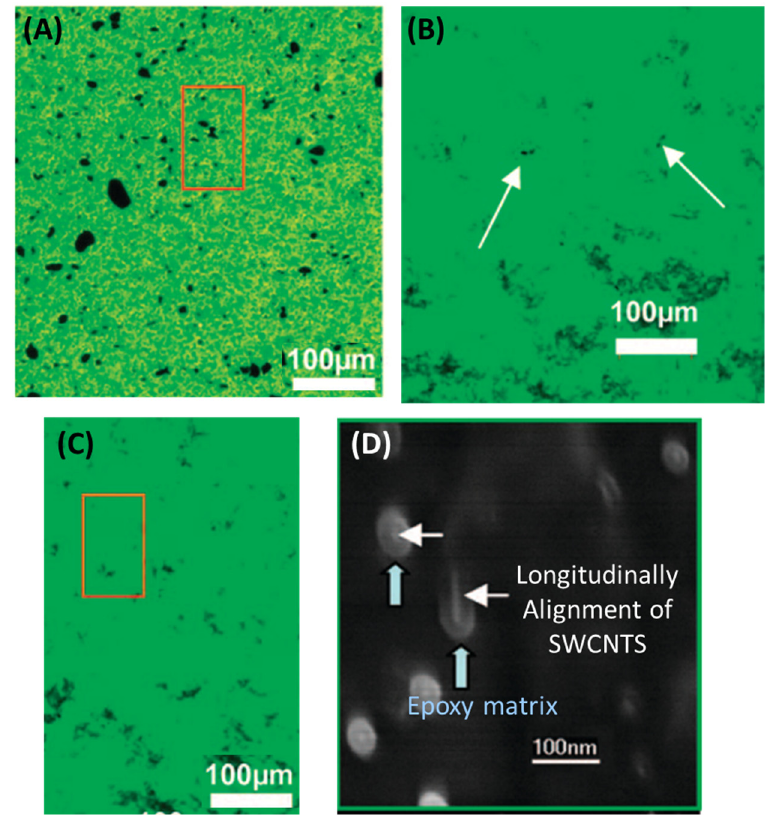
Figure 5. Microscopic images of ( A ) poly(amidoamine)-free single-walled carbon nanotube-based epoxy matrix, PAMAM/SWCNTs/EP, with ( B ) 1 and ( C ) 2 as number generation and ( D ) field emission scanning electron microscope (FESEM) images of PAMAM/SWCNTs/EP with grafting generation 2 (adapted from [22]). (Reprinted (adapted) with permission from Che, J.; Yuan, W.; Jiang, G.; Dai, J.; Lim, S.Y.; Chan-Park, M.B. Epoxy Composite Fibers Reinforced with Aligned Single-Walled Carbon Nanotubes Functionalized with Generation 0 − 2 Dendritic Poly(Amidoamine). Chem. Mater. 2009 , 21 , 1471–1479 [22]. Copyright (2020) American Chemical